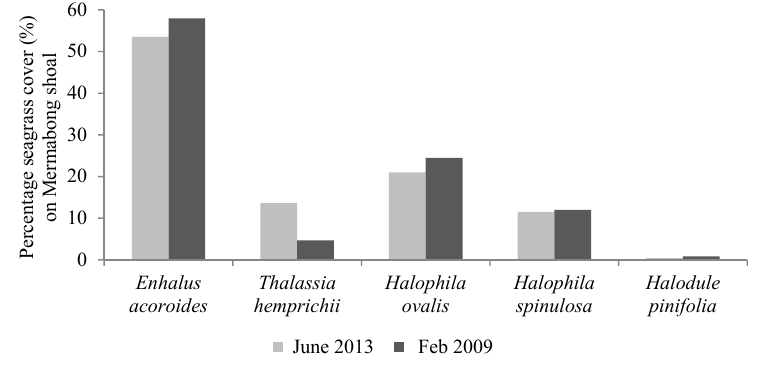
Figure 5. Common seagrass species found on Merambong shoal and its vicinity.